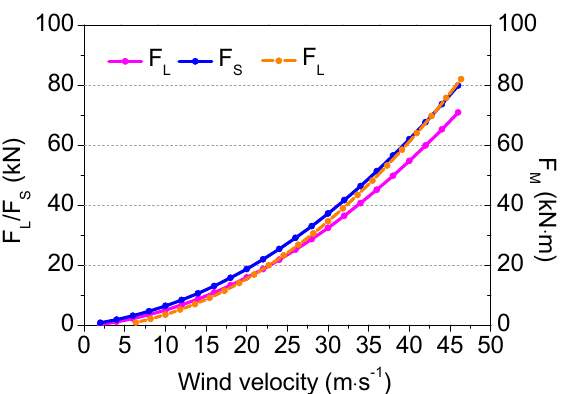
Figure 10. As in Figure 9 but the impact of wind velocity variations assuming an easterly wind (90°). With the same conditions used to evaluate the effect of the rail vehicle velocity (Figure 11), the three forces increase approximately linearly, with F L having the slowest rate. When the vehicle velocity − 1 − 1 is 40 km · h (80 km · h ), the three forces are 13.3 (17.0) kN, 15.8 (22.1) kN, and 16.9 (24.3) kN · m, respectively. Thus, if the vehicle velocity is doubled, the aerodynamic forces increase by 0.28, 0.40, and 0.44 times, respectively. As the vehicle aerodynamic forces are more sensitive to wind velocity than vehicle velocity, when wind velocity doubles, the vehicle velocity needs to be reduced by a greater factor to ensure stability.